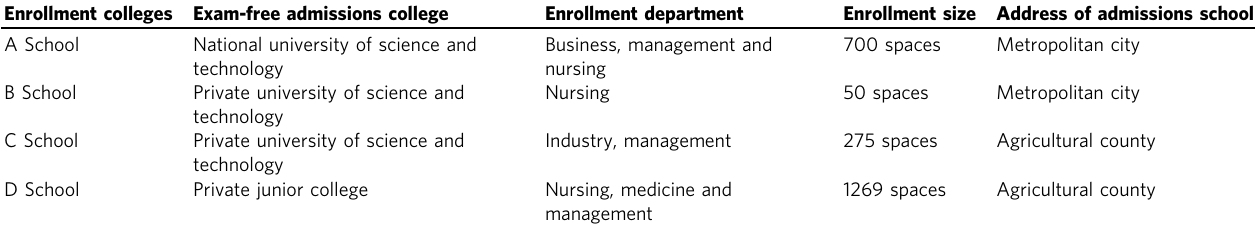
Table 1 Characteristics of four colleges in the exam-free admissions system in